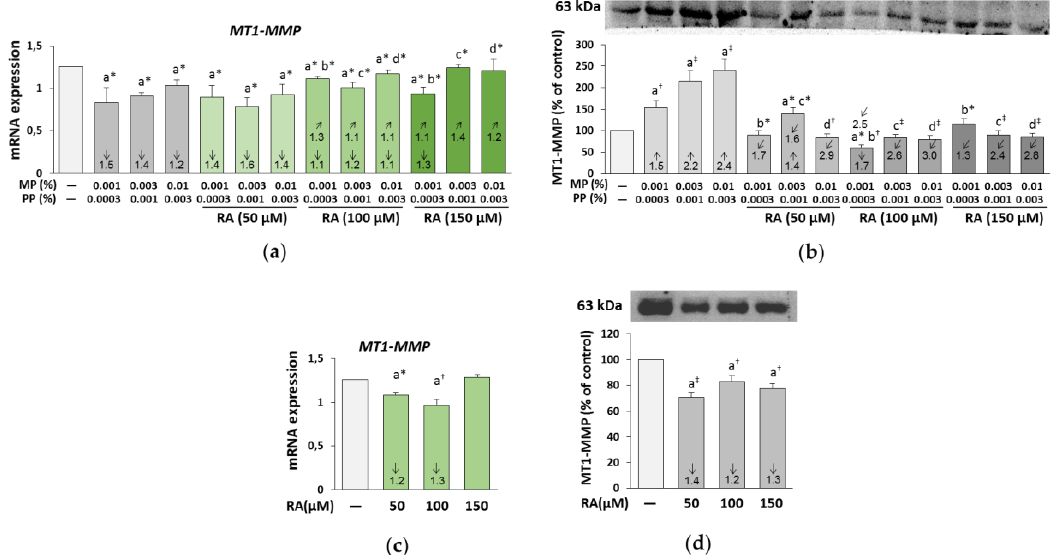
Figure 9. The influence of rosmarinic acid (RA) on the expression of membrane type-1 matrix metalloproteinase (MT1-MMP) at mRNA ( a , c ) and the protein ( b , d ) levels in the fibroblasts treated with methylparaben (MP) and n-propylparaben (PP) ( a , b ), and untreated cells ( c , d ). Expression of genes was assayed by real-time PCR, values represent the mean ± SD of three experiments done in duplicate ( a , c ). Representative gels of Western blotting, the intensity of the bands was quantified by densitometry and normalized to β -actin, values represent the mean (% of control) ± SD of three experiments ( b , d ). Statistically significant di ff erences are marked as: a vs. control, b vs. 0.001% MP and 0.0003% PP, c vs. 0.003% MP and 0.001% PP, d vs. 0.01% MP and 0.003% PP; * p < 0.05; † p < 0.01; ‡ p < 0.001. The values in the bars show a factor of change in comparison to the control ( ↑ , increase; ↓ , decrease) or to the respective samples treated with parabens alone (MP and PP) ( ↗ , increase; ↙ , decrease).